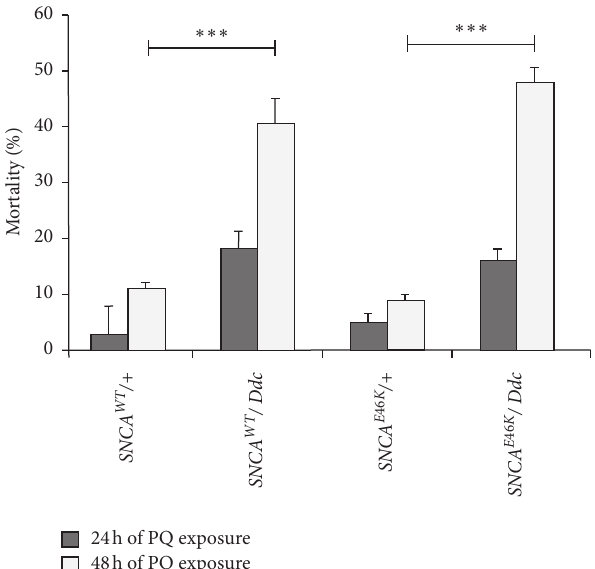
Figure 9: SNCA E46K flies are more sensitive to PQ toxicity. The mortality induced by PQ in flies exposed to the neurotoxin for 48 h was significantly high in SNCA -expressing transgenic insects when compared to control genotypes: SNCA WT /+ and SNCA E46K /+ ( ∗∗∗ p < 0 . 001; by t-test n � 32). The average mortality of 46% is observed for SNCA WT /Ddc following 48h PQ treatment while 49% for the SNCA E46K /Ddc